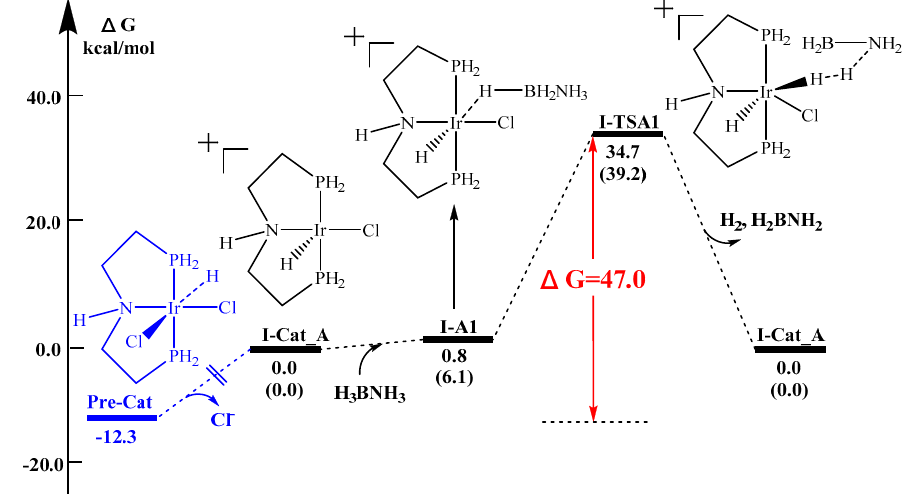
Figure 4. Reaction potential energy surface (kcal/mol) of Pathway I-A. Energies are calculated at B3LYP/LanL2DZ-6-311++G(d,p), in the solvent THF and H 2 O (in brackets).